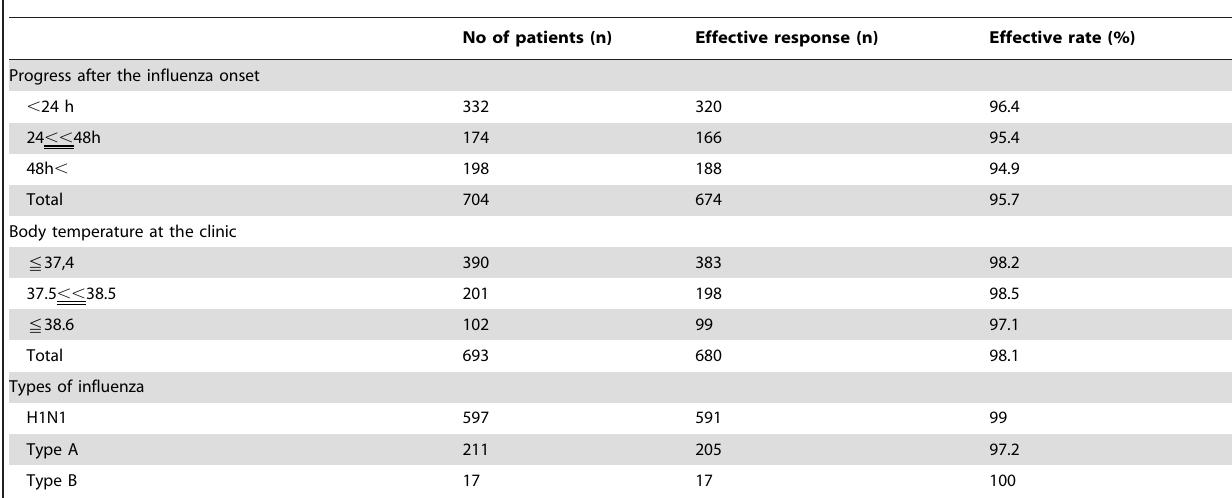
Table 4. Effects oflaninamivir on patients with influenza of 2011/2012 seasons.